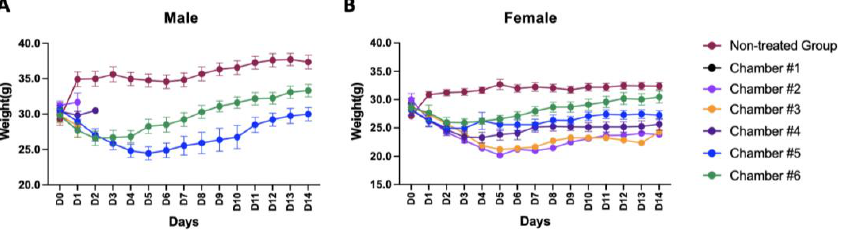
Figure 3. Body weight changes during the experiment. ( A ) For male animals, high concentrations of ClO 2 gas (Chamber #1–Chamber #4) resulted in high mortality. However, mice in Chamber #5 and Chamber #6 recovered their body weight gradually from D4 – 5. ( B ) For female animals, all animals in Chamber #1 died after exposure to a concentration of 240 ppm or more. However, animals corresponding to the remaining concentrations were resistant to ClO 2 gas and survived compared to males. Error bars represent mean ± SEM.